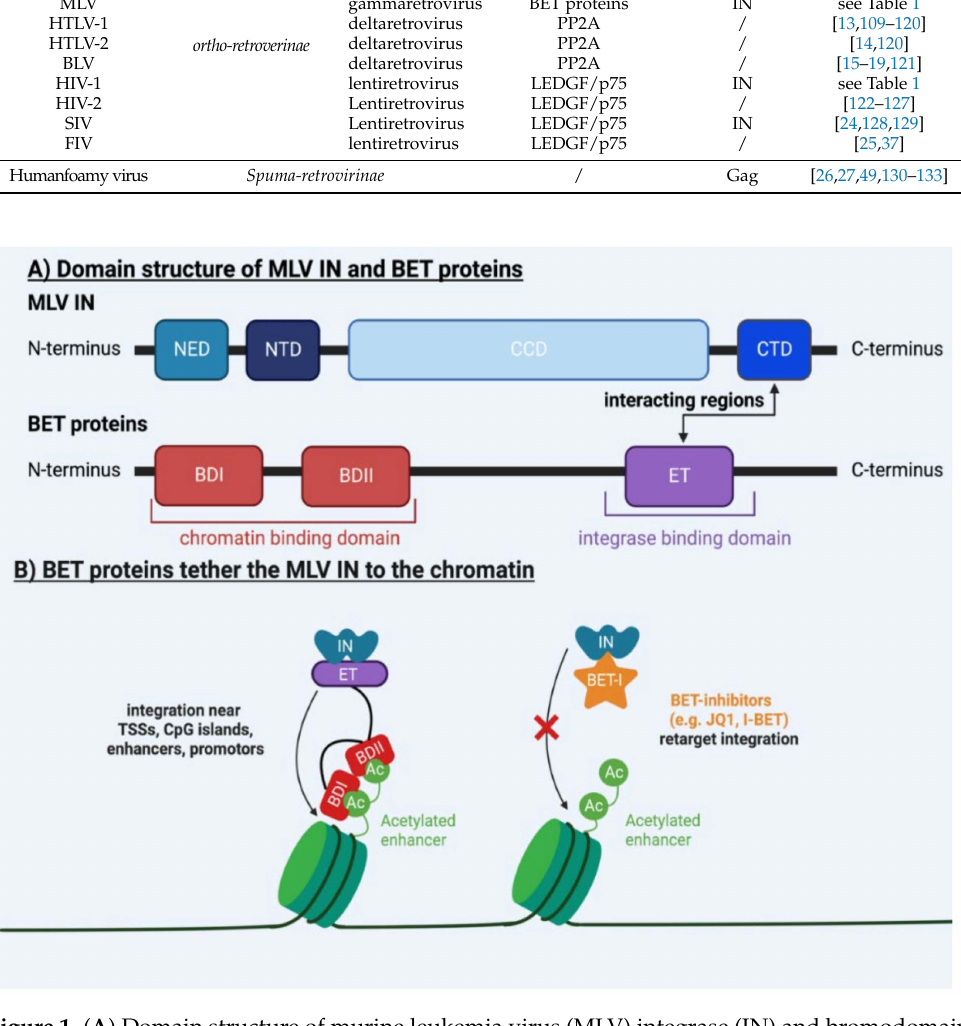
Figure 1. ( A ) Domain structure of murine leukemia virus (MLV) integrase (IN) and bromodomain and extra–terminal motif (BET) proteins. The MLV IN consists of an N–terminal extension domain (NED), an N–terminal domain (NTD), a catalytic core domain (CCD) and a C–terminal domain (CTD) [4]. BET proteins consist of two bromodomains (BD), BDI and BDII, that bind acetylated lysines in the nucleosomes, and an extra–terminal (ET) domain that interacts with the CTD of the MLV IN [28–34]. ( B ) BET proteins tether the MLV IN. Through the combined interaction of the ET domain of BET proteins (which binds the CTD of the MLV IN) and BDI and BDII (which bind the acetylated chromatin), BET proteins tether the MLV IN to acetylated chromatin regions such as enhancers [28–34]. BET inhibitors, such as JQ1 and I–BET, retarget the integration of MLV away